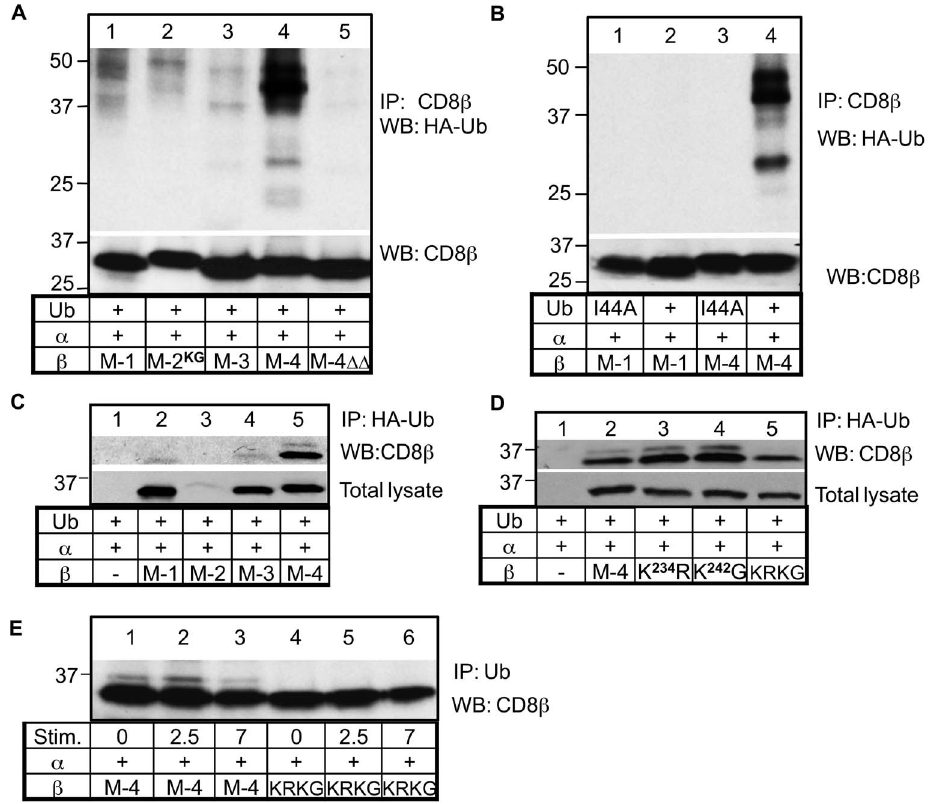
Figure 4. M-4 cytoplasmic tail binds to ubiquitinated proteins and is modified itself by ubiquitination. ( A ) HEK-293T cells co-transfected with plasmids expressing HA-tagged ubiquitin, CD8 a and each CD8 b isoform or mutant proteins. After 48 hours cells were lysed with 1% BRIJ 97 and immunoprecipitated with anti-CD8 b mAb, run on a polyacrylamide gel, transferred to a membrane and probed with the anti-HA antibody. Gels were reprobed with an anti-CD8 b antibody (5F2). Small differences in size reflect different lengths of the isoforms. ( B ) Co-transfection of HEK-293T cells with either wild type HA-Ub or I 44 A mutant of HA-Ub. The immunoprecipitation and Western blotting procedures were performed as in (A). ( C ) Determination of direct ubiquitination of CD8 b isoforms. Cells expressing individual isoforms were immunoprecipitation with anti-HA mAb followed by blotting with anti-CD8 b antibody. An aliquot of total cell lysate was similarly analyzed. ( D ) Effect of lysine mutants on M-4 ubiquitination. Cells expressing M-4 wild-type, single lysine (K 234 R, K 242 G) or double lysine (K 234 R/K 242 G labeled KRKG) mutants were lysed and protein analyzed as described in (C). ( E ) The JM T cells expressing CD8 a and either CD8 b M-4 or the double lysine mutant KRKG were incubated with the anti-CD8 a (OKT8) and anti-CD3 (OKT3) mAbs for 0, 2.5 or 7 minutes at 37 u C. Cells were lysed, immunoprecipitated with the anti-Ub mAb followed by Western blotting with the anti-CD8 b antibody. A representative of three independent experiments is shown in each panel.